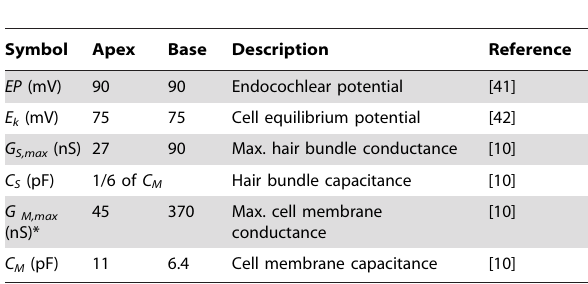
Table 1. Outer hair cell electrical properties.